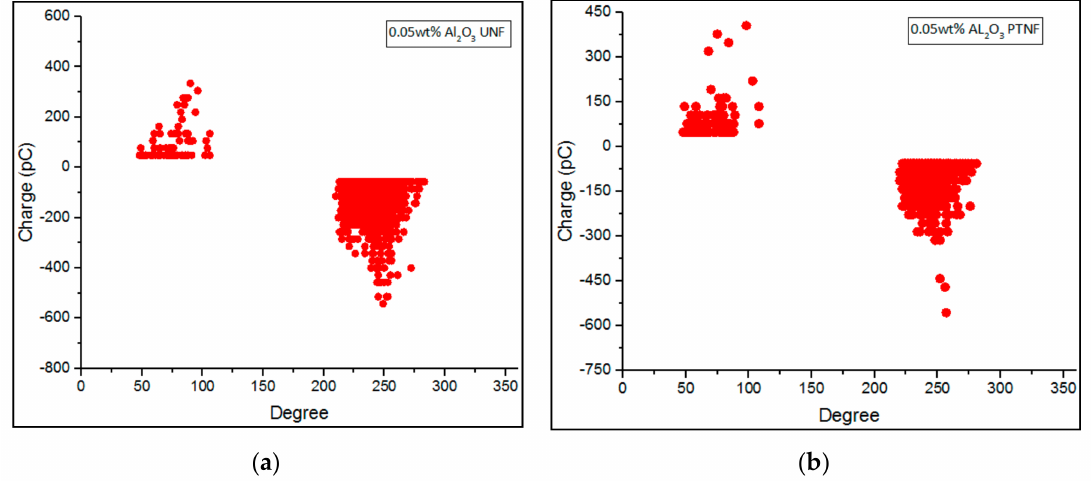
Figure 9. Phase—resolved PD patterns of ( a ) 0.05 wt% Al 2 O 3 UNF and ( b ) 0.05 wt% Al 2 O 3